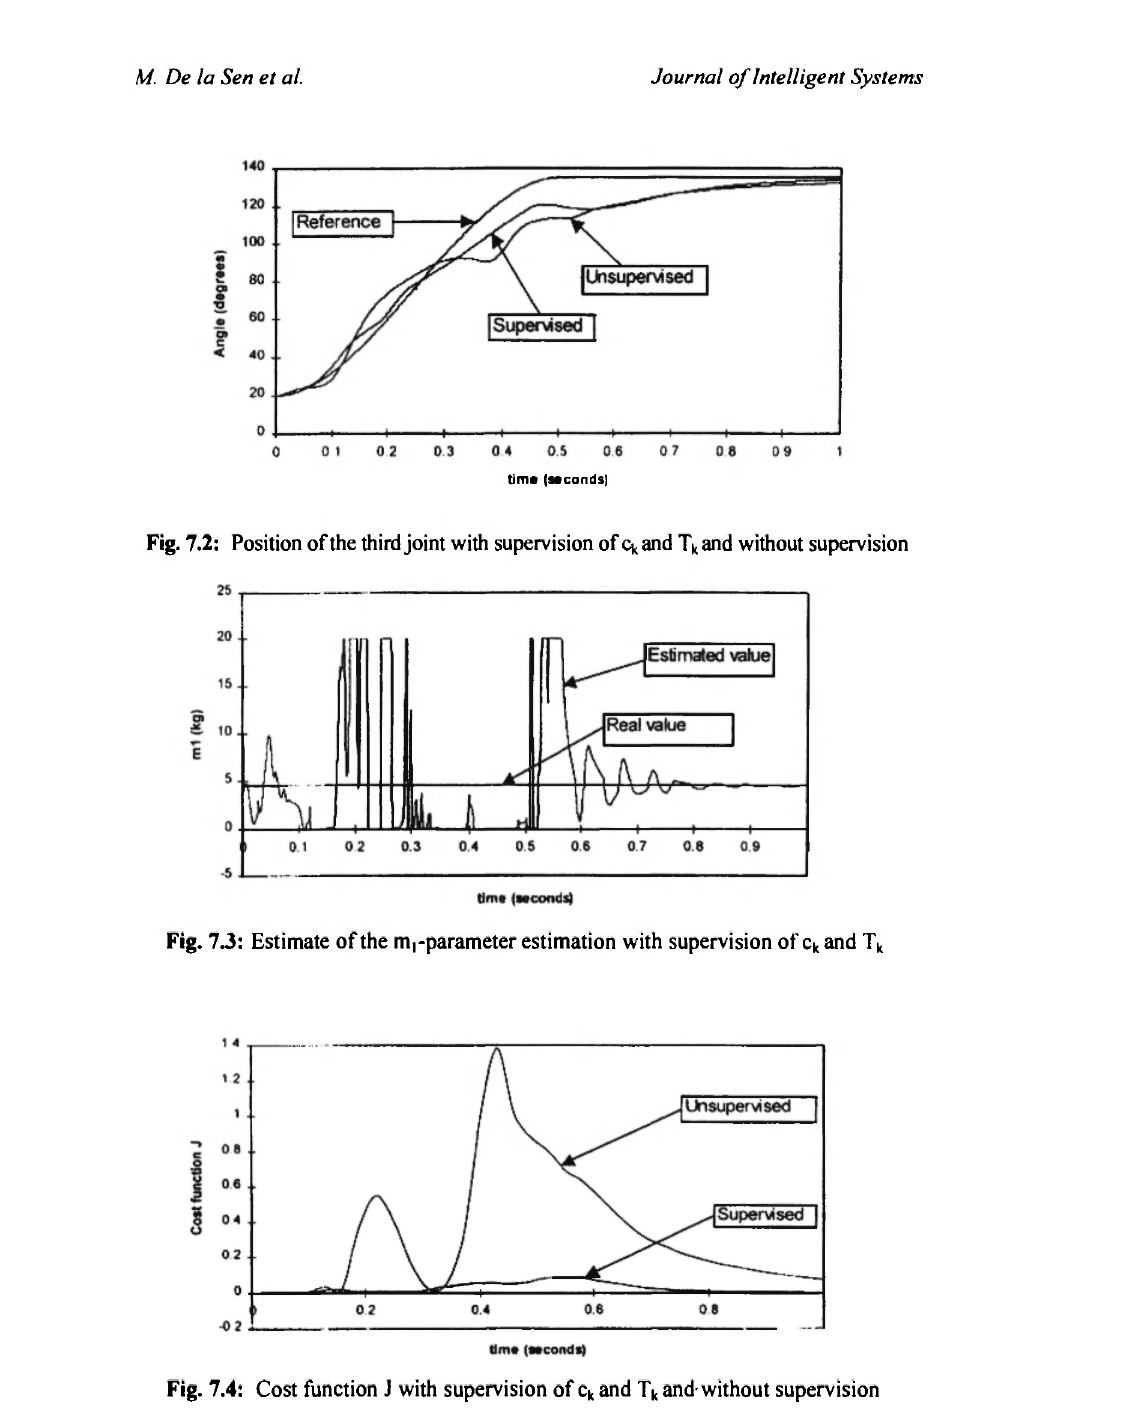
Fig. 7 .4: Cost function J with supervision of c k and T k and-without supervision